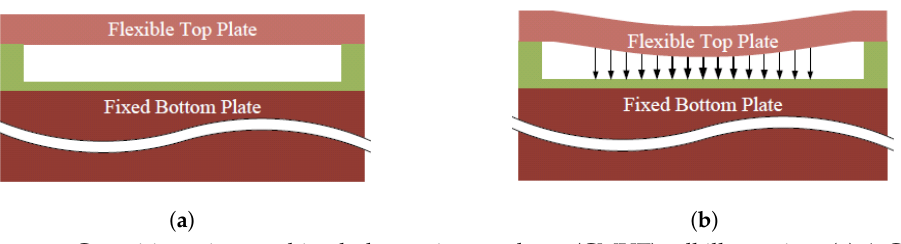
Figure 1. Capacitive micromachined ultrasonic transducer (CMUT) cell illustration. ( a ) A CMUT cell is composed of a flexible top plate and a fixed bottom plate. ( b ) A direct current (DC) bias is applied during the operation that deflects the top